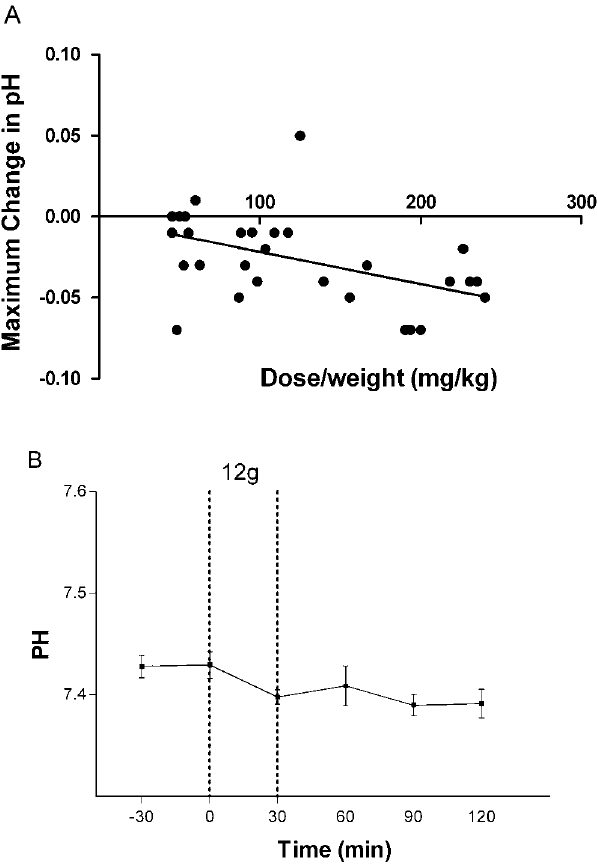
Figure 5. Effects of L-arginine hydrochloride infusion on venous blood chloride concentrations. Figure 5A: Relationship between dose/weight (mg/kg) of infused L-arginine and the maximal decrease in venous blood chloride at any time during or in the two hours following infusion (n=30, r=0.6, p , 0.001). Figure 5B: Venous blood chloride in patients before and after 30 minute administration of the highest dose of L-arginine (12 g; n=10). Shaded area indicates time of L-arginine infusion. Dots and bars indicate mean 6